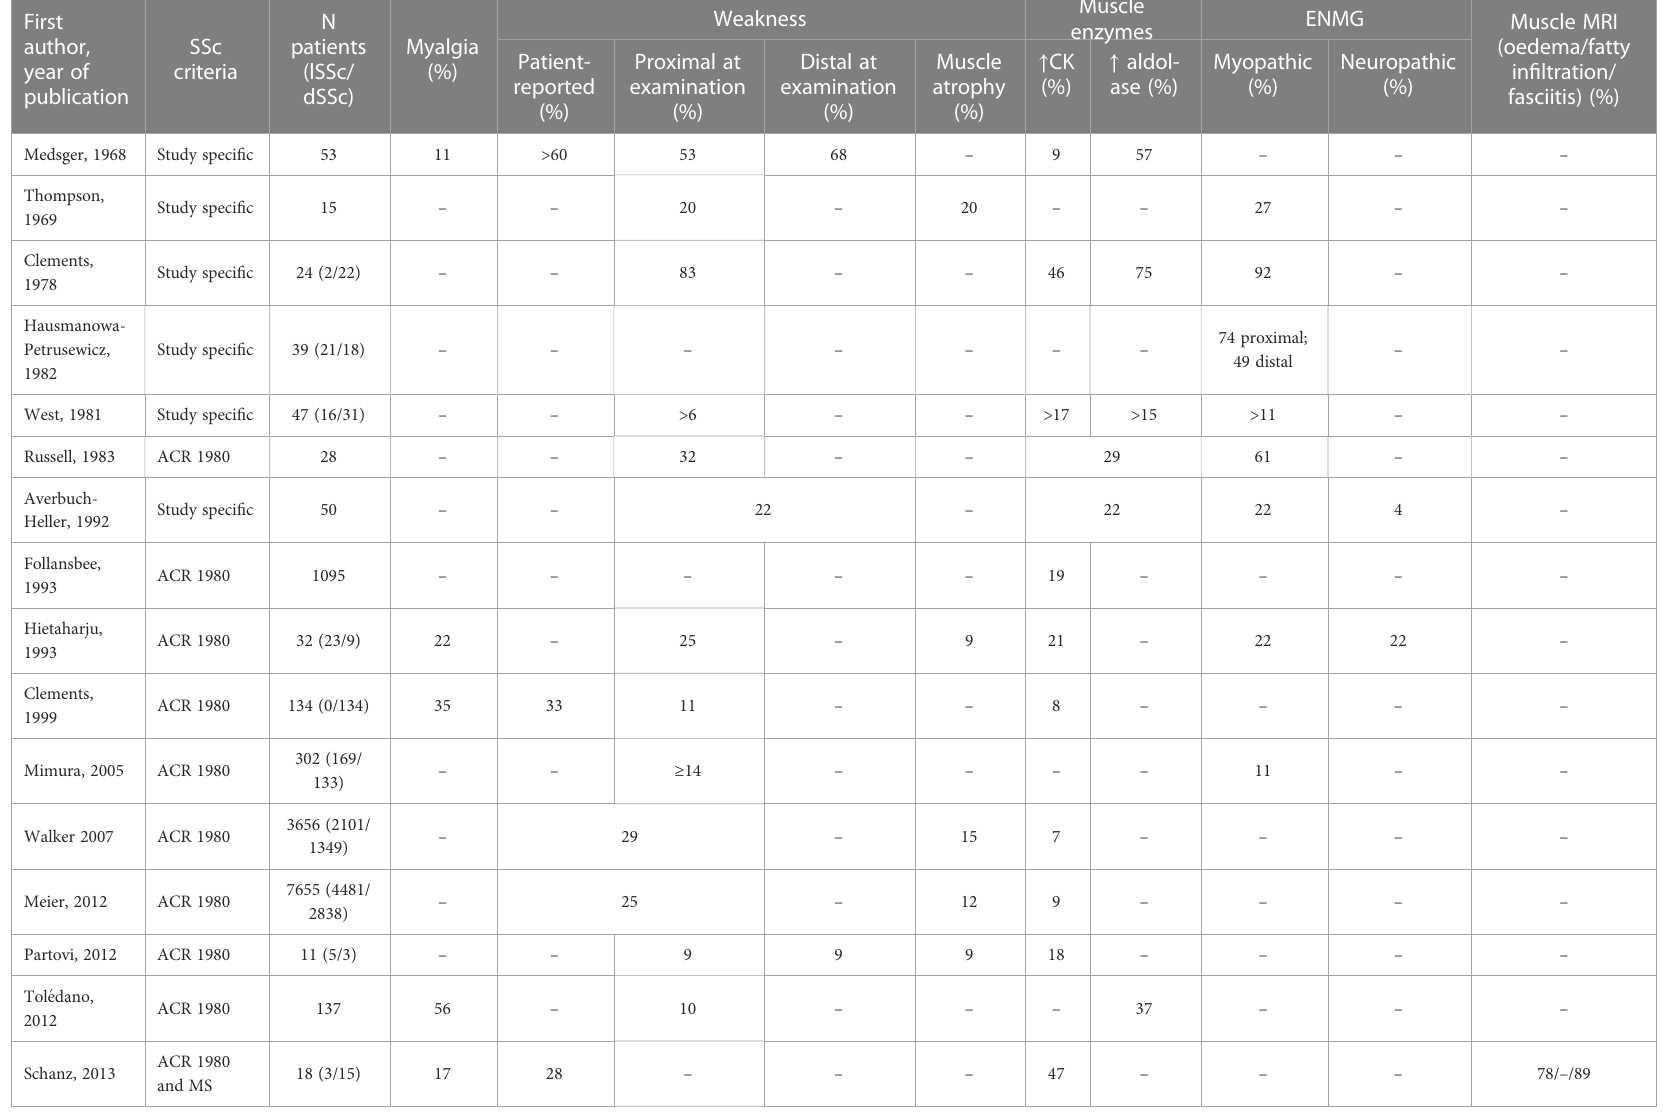
TABLE 1 Prevalence of muscle features in systemic sclerosis